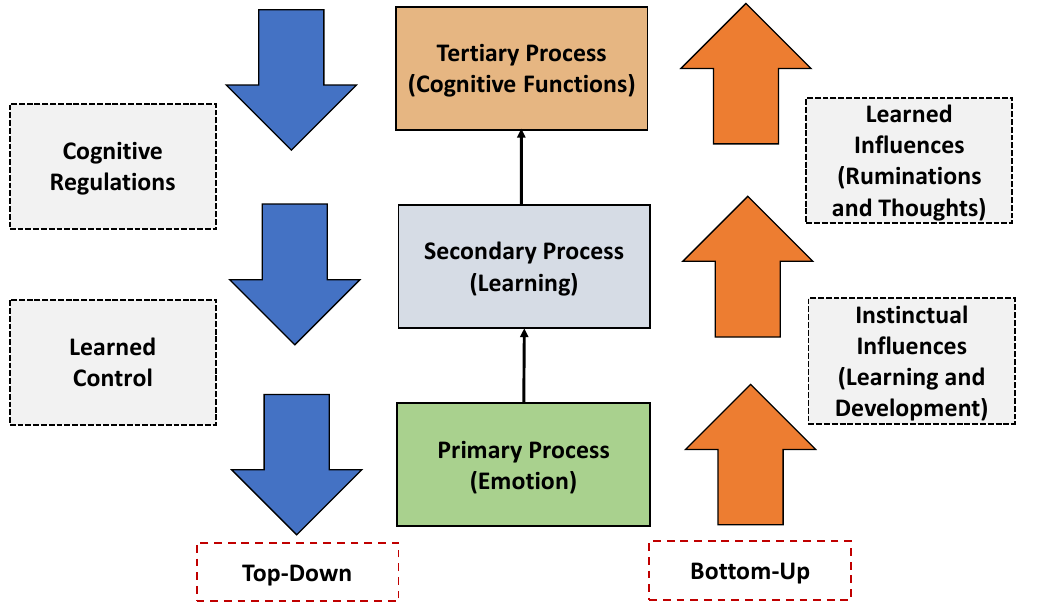
Figure 2. Studying human emotions to generate appropriate decisions based on control and cognitive regulations (top-down and